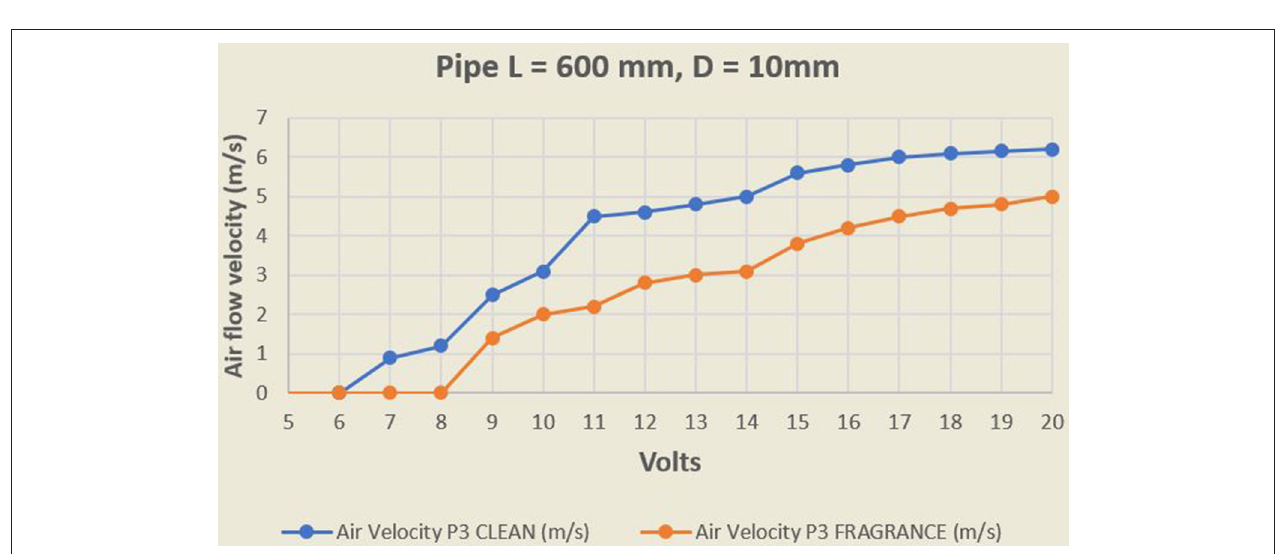
FIGURE 2 | Olfactory display with the reference points for fluid dynamic testing: P1, at the exit of the DC fan; P2, at the exit of the selector; and P3, at the exit of a delivery tube 600mm long.